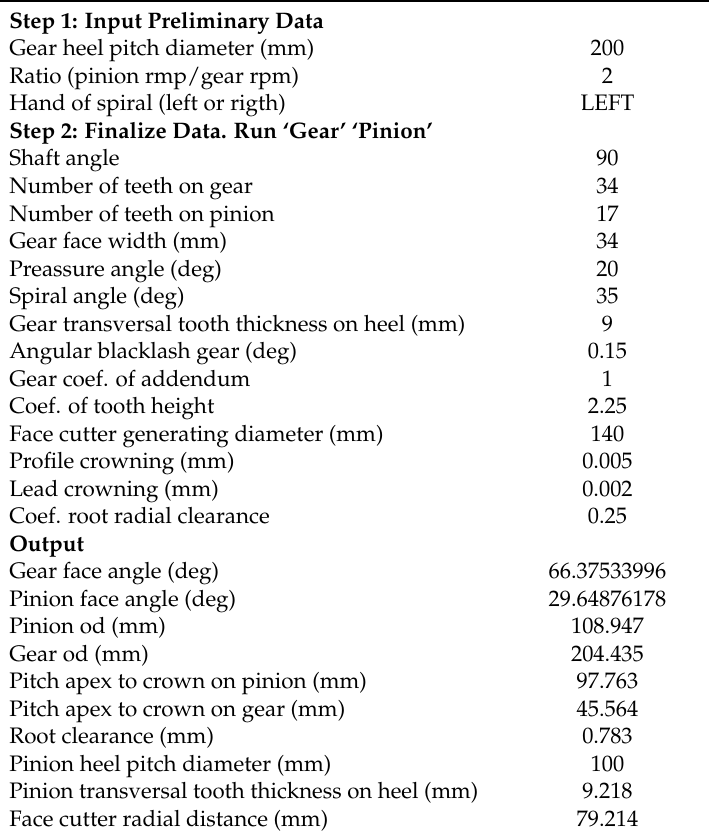
Table 2. Gear input and output data 3D spiral bevel gear